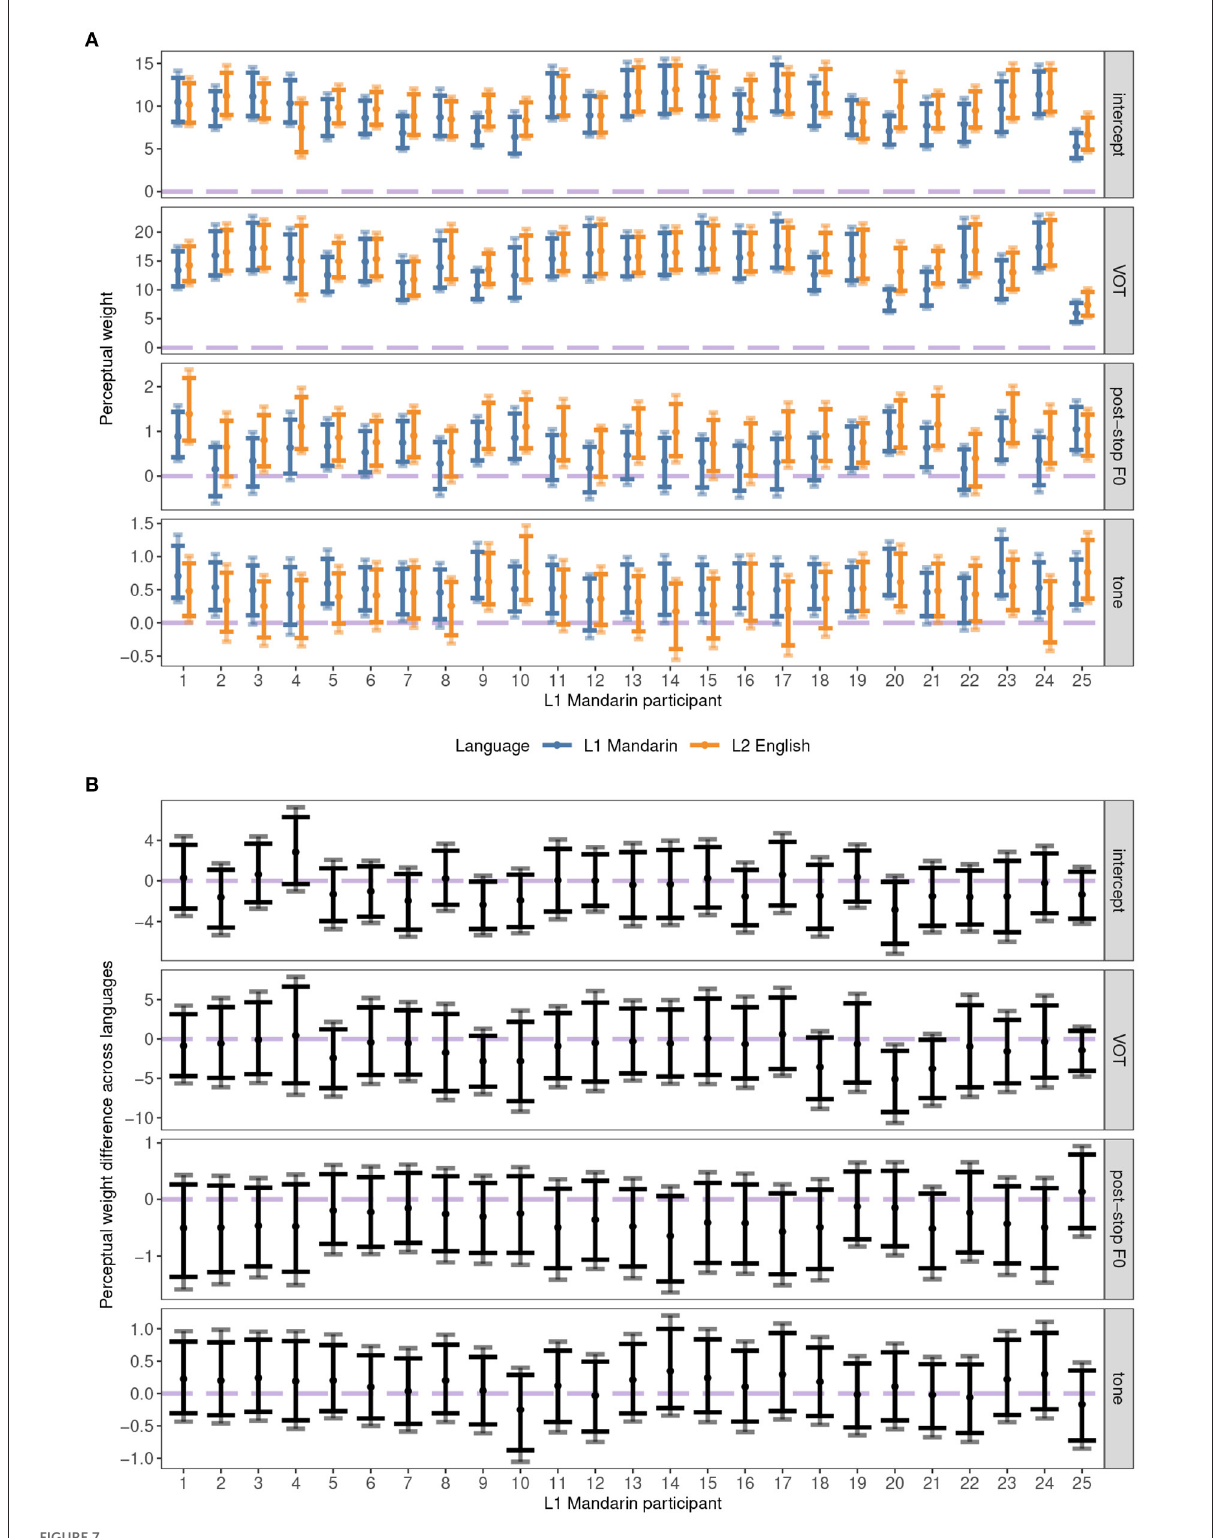
FIGURE7 Individuals’ estimated weights from the perceptual model. (A) Distributions of individual weights along various dimensions for Mandarin and English. (B) Differences in cue weights along the same dimension across languages. In both figures, posterior means are represented by the dots. The 89% CrIs are marked by the inner error bars, while the 95% CrIs are marked by the outer error